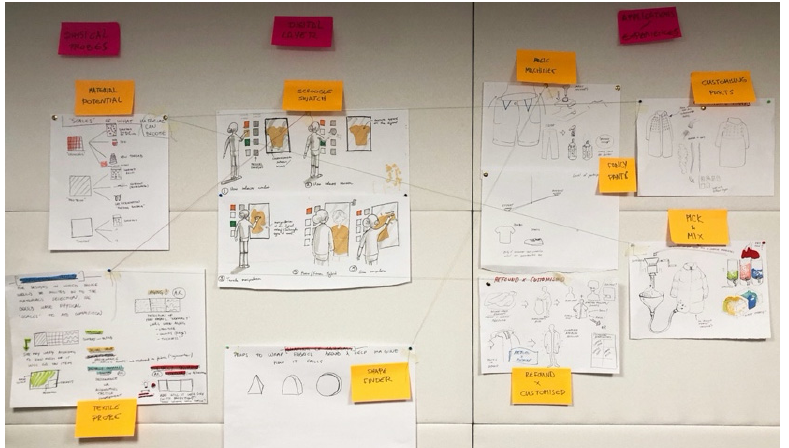
Figure 2. Initial sketches for